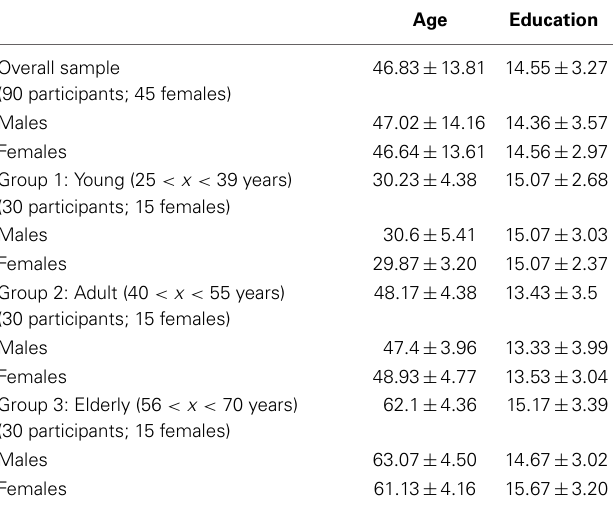
Table 1 | Demographic information of the participants.